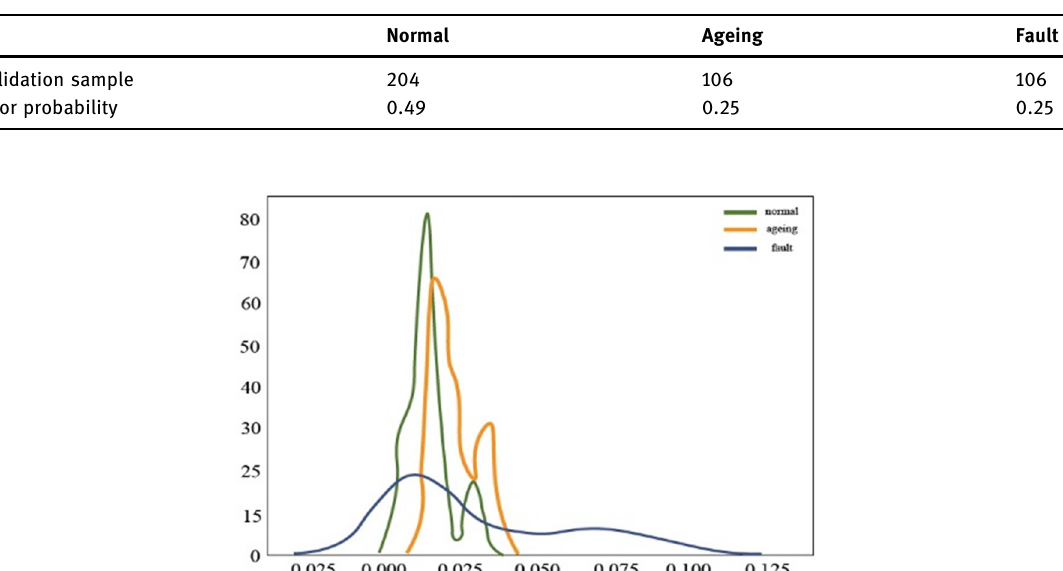
Table 2: Training samples and prior probability table